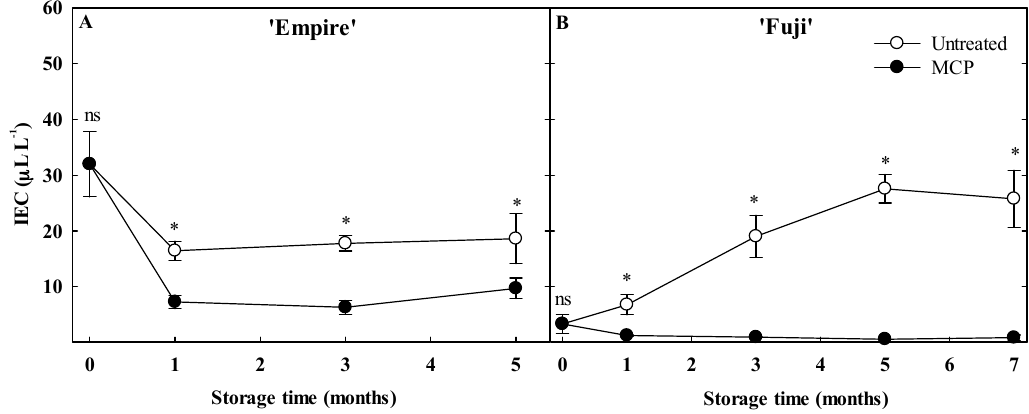
Figure 1. Internal ethylene concentration (IEC) in browning of ‘Empire’ ( A ) and ‘Fuji’ ( B ), either untreated or treated with 1 µL·L − 1 1-MCP, and stored at 0.5 °C in air storage for up to five and seven months, respectively. Bars represent error of the means (S.E.M; n = 5) when larger than the dimension of the symbol. ns and * indicate non-significant and significant differences between untreated and 1-MCP treatments at p < 0.05, respectively.